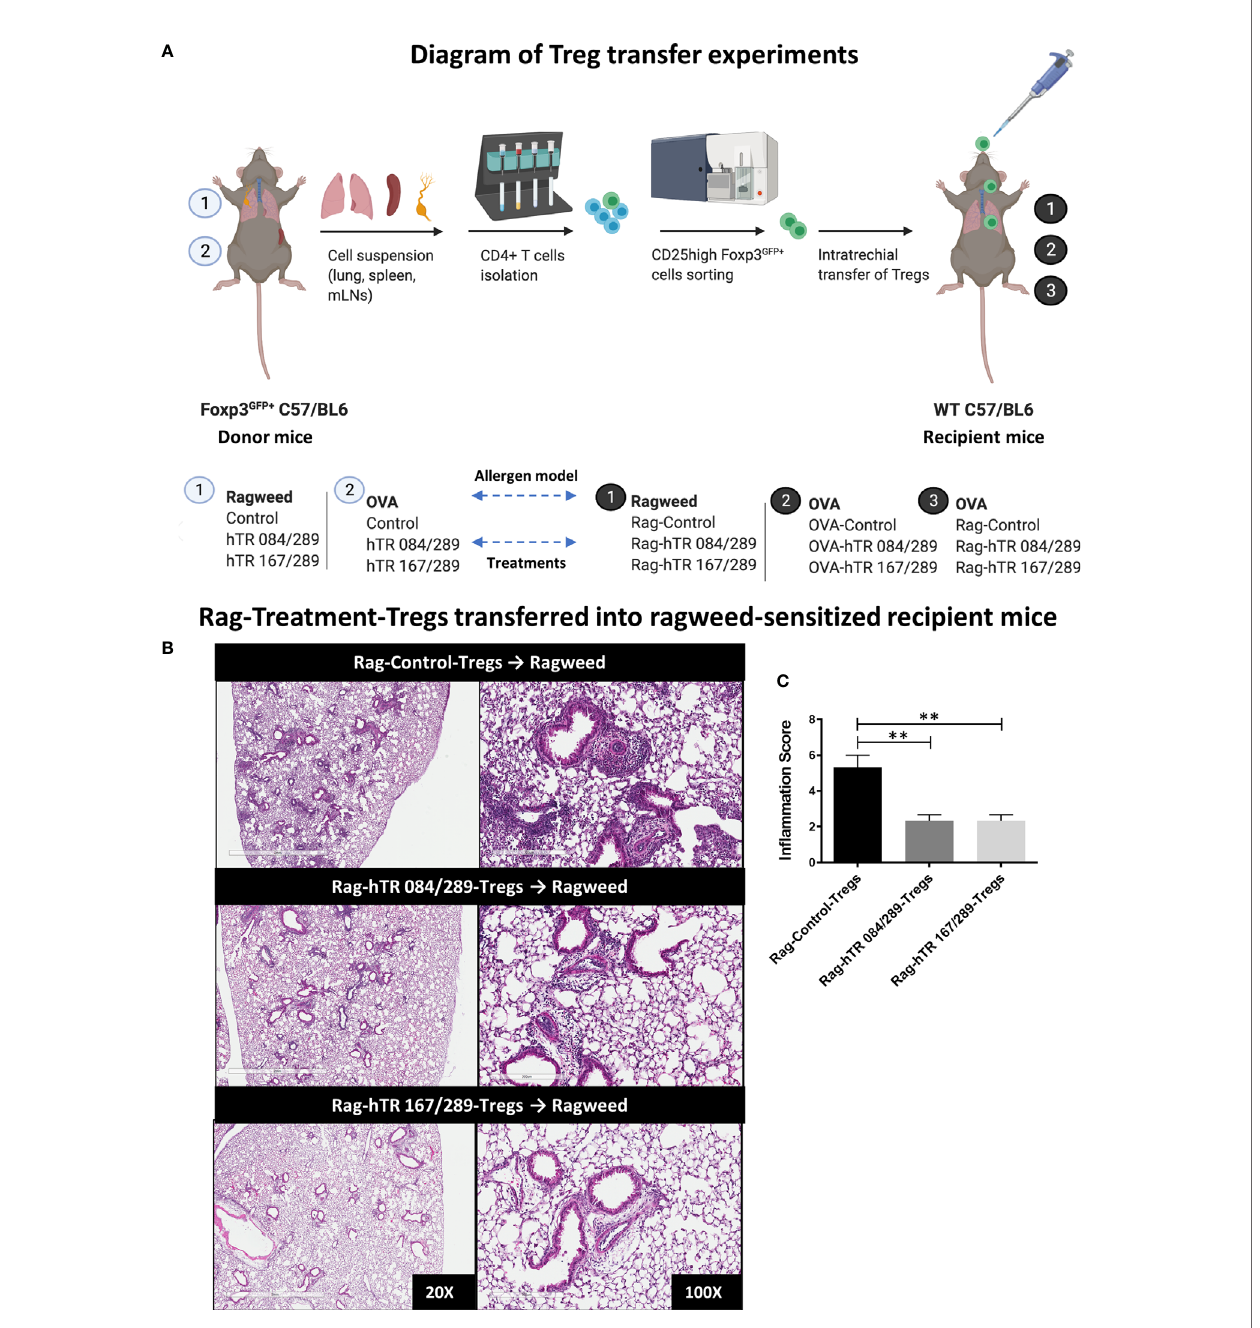
FIGURE 5 | Tregitopes-Tregs are more ef fi cient at improving murine airways disease than Control-Tregs in vivo . (A) Diagram depicting the Treg transfer experiment used to determine the ef fi cacy and antigen-speci fi city of Tregs from Tregitopes treated allergic mice. Donor mice were sensitized with either Ragweed or OVA and ① ② or ). Treg (CD25highFoxP3-EGFP+) cells were isolated from lungs, spleen and mediastinal lymph treated with Control and Tregitope combinations as indicated ( nodes of donor mice and transferred to recipient mice. Sensitization with antigen primed-BMDCs in recipient mice was performed as described in Methods . On day 9 after sensitization, Control Treg or Antigen-Speci fi c Tregs were adoptively transferred to the lungs of sensitized recipient mice as indicated followed by antigen challenge on day 10. (B) Ragweed-sensitized recipient mice were treated with 50,000 Control Treg, Rag-hTR 084/289-Tregs or Rag-hTR 167/289-Tregs derived ➊ , then challenged with Ragweed, and lungs were harvested after 72 hours, H&E-stained lung sections were examined by microscopy (20X, 100X) (C) and Treg scored for in fl ammation by two independent observers. Representative of 2 independent experiments, n = 3-4. **p, 0.01, one-way ANOVA